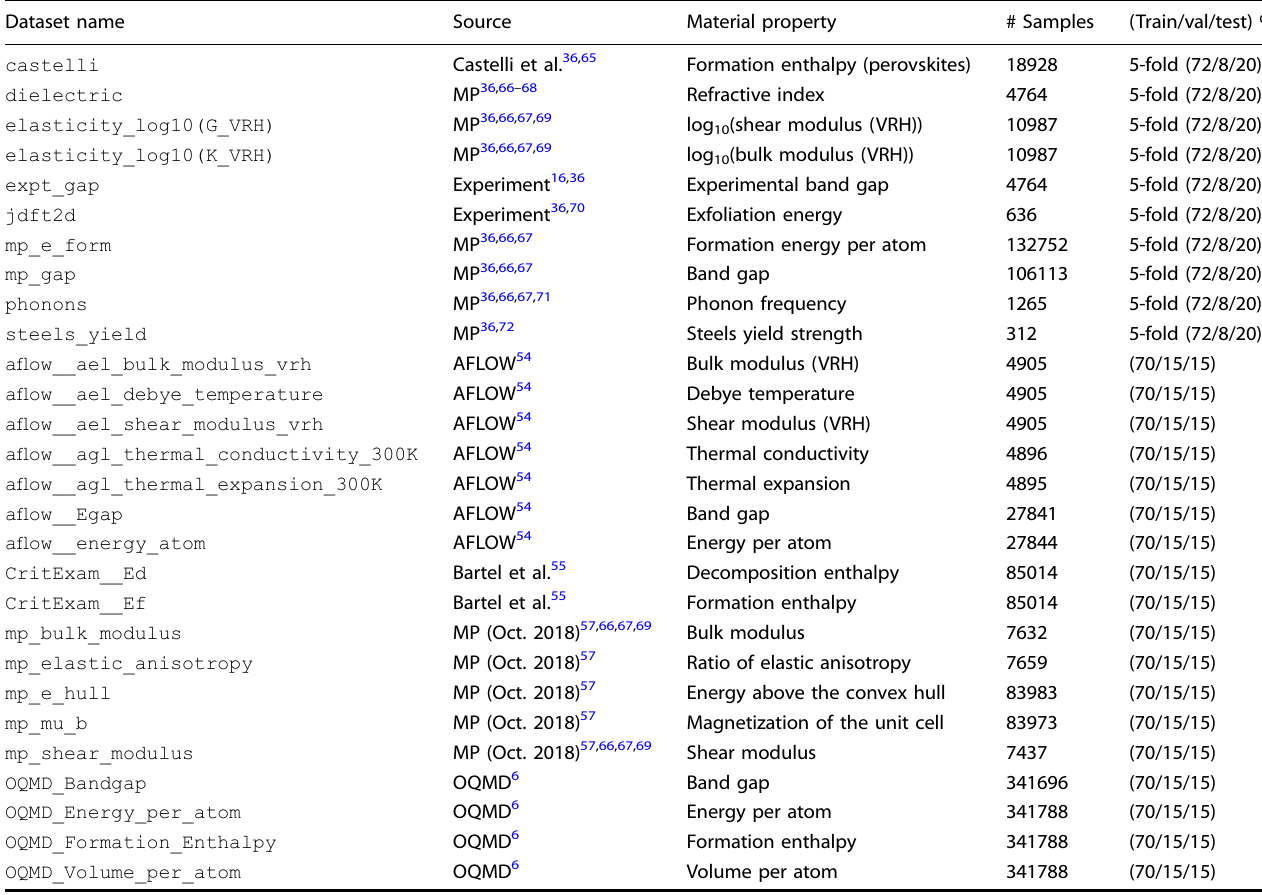
Table 1. Benchmark datasets. List of all 28 material properties used to benchmark the ML models in this work, together with the dataset size and the original training, validation, and test set